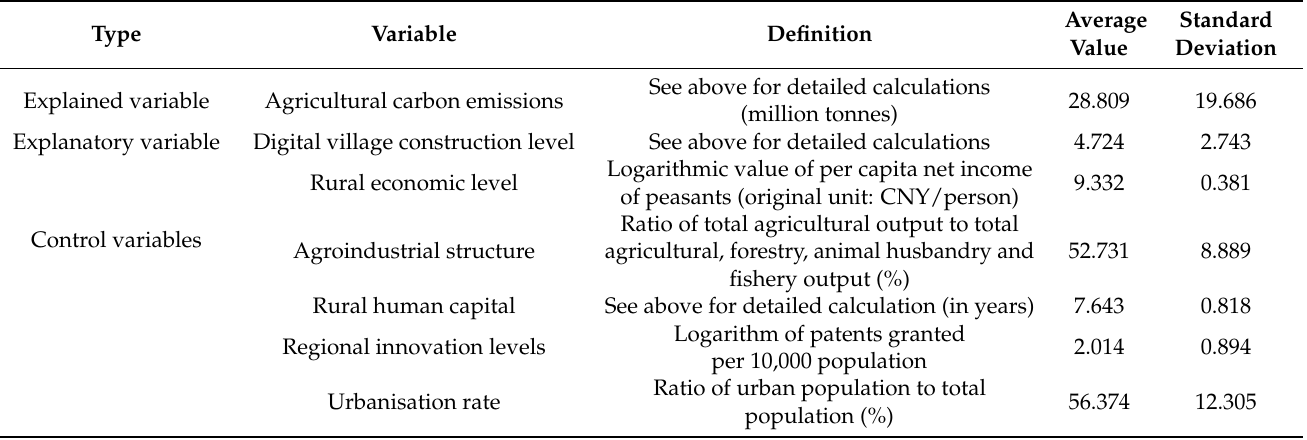
Table 5. Variable definitions and descriptive